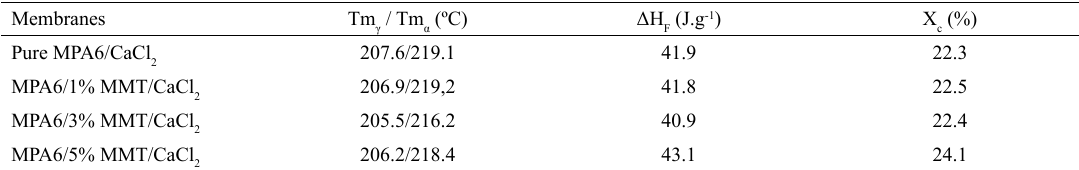
), melting enthalpy (ΔH m